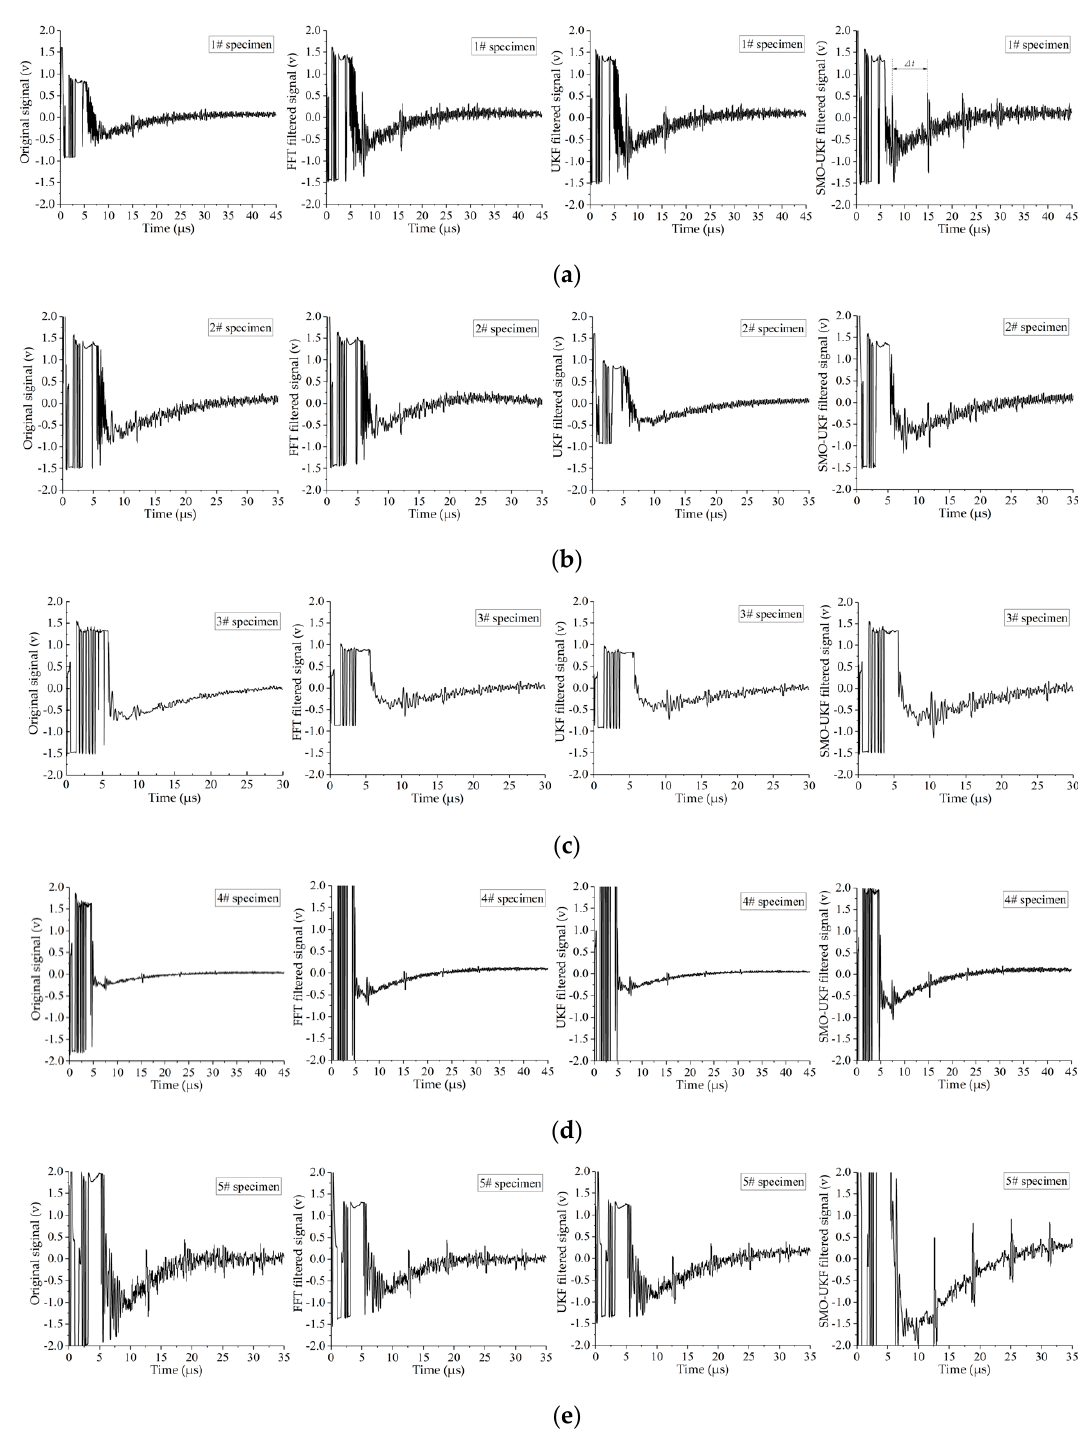
Figure 4. Comparison before and after filtering by FFT, UKF, and SMO–UKF for: ( a ) specimen #1 ( b ) specimen #2, ( c ) specimen #3, ( d ) specimen #4, and ( e ) specimen #5.